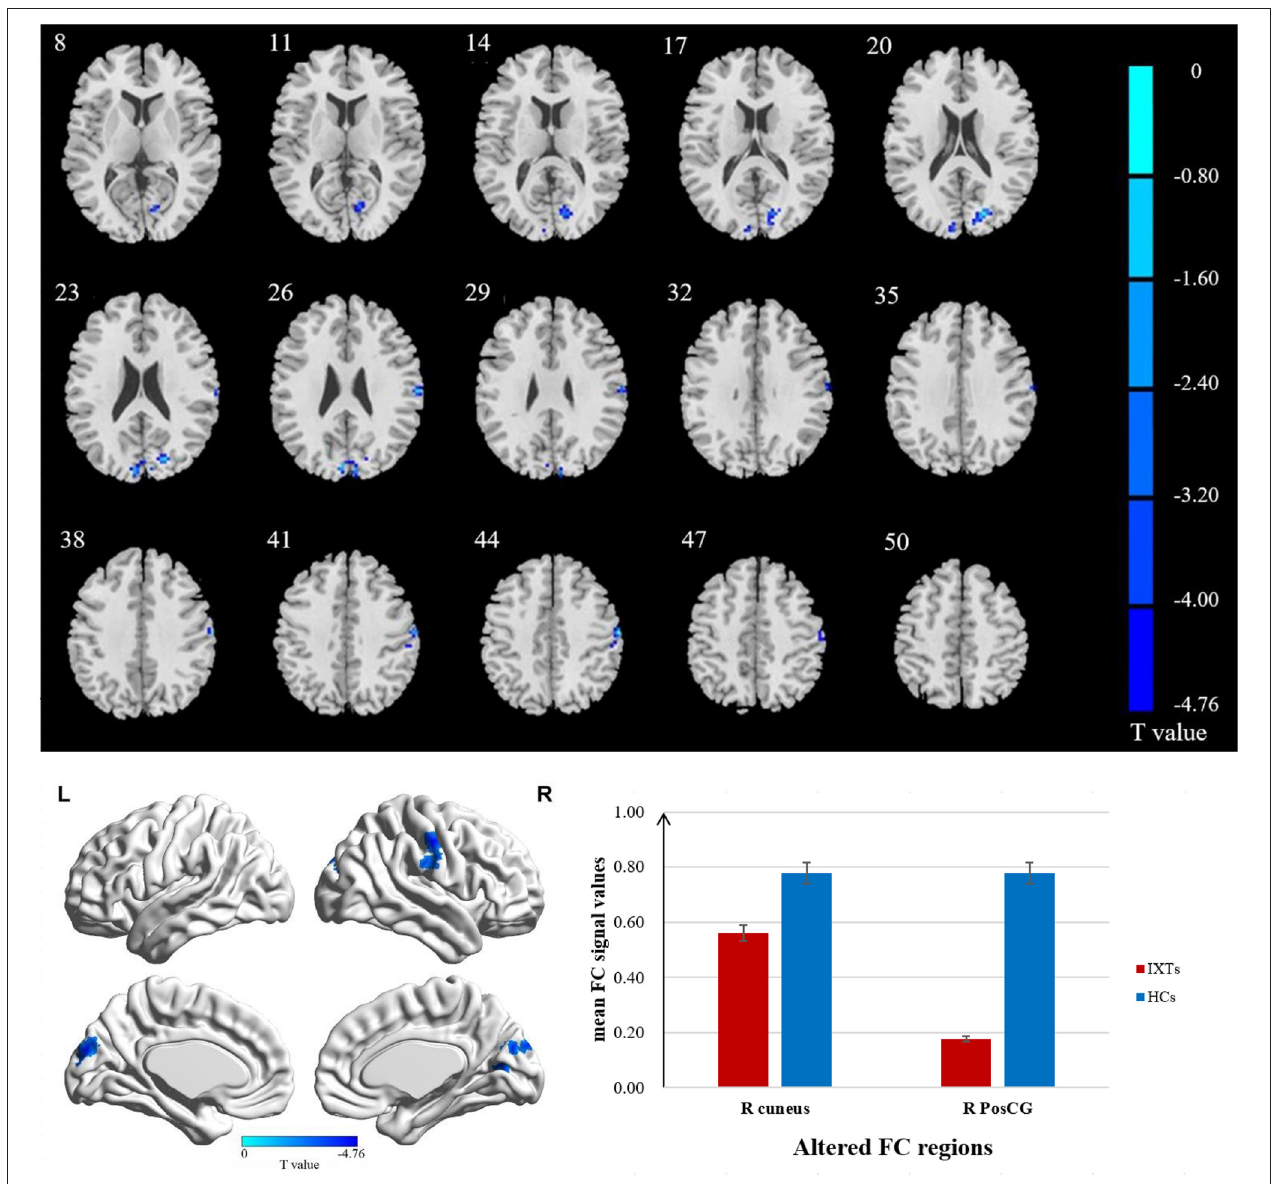
FIGURE 2 | Brain regions demonstrate statistically significant differences between two groups in terms of FC in the left BA17 (GRF corrected, P < 0.05). Decreased FC values were observed in the right cuneus and right postcentral gyrus (PosCG). The details of the negative regions can be found in Table 2 . IXTs, Intermittent exotropia; HCs, Healthy controls; BA, Brodmann area; FC, Functional connectivity.